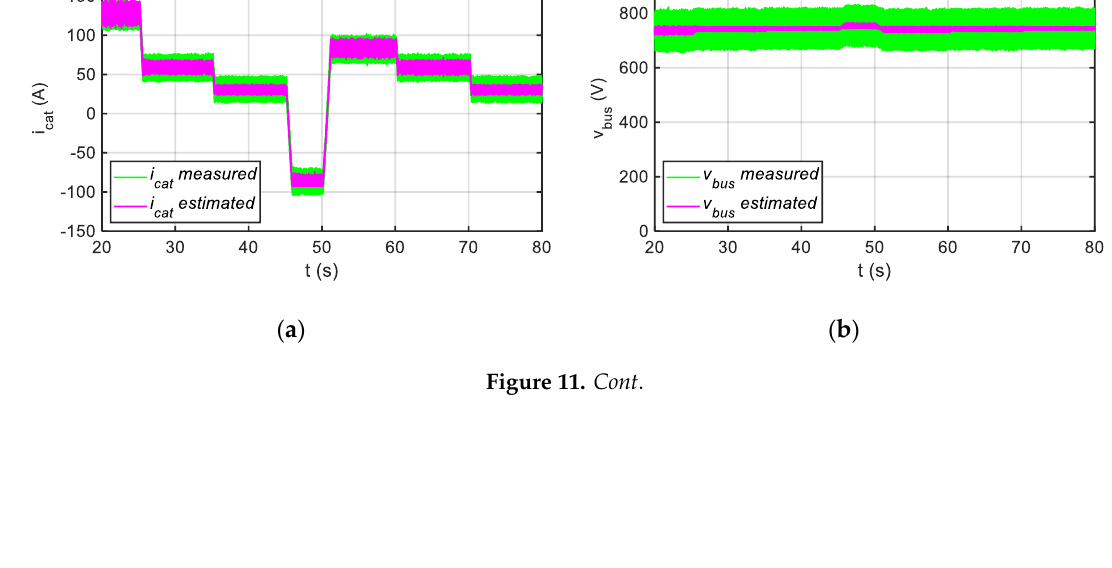
( d ) Figure 11. Injection noise in sensor measurements. The noise injected is uniformly distributed random noise with a frequency of 1 kHz. ( a ) Measured and estimated catenary current. ( b ) Measured and estimated DC-link voltage. ( c ) Catenary current fault reconstruction. ( d ) DC-link voltage fault reconstruction. Table 4. Summary of deviation between fault injected and fault reconstruction average values. Motor Torque